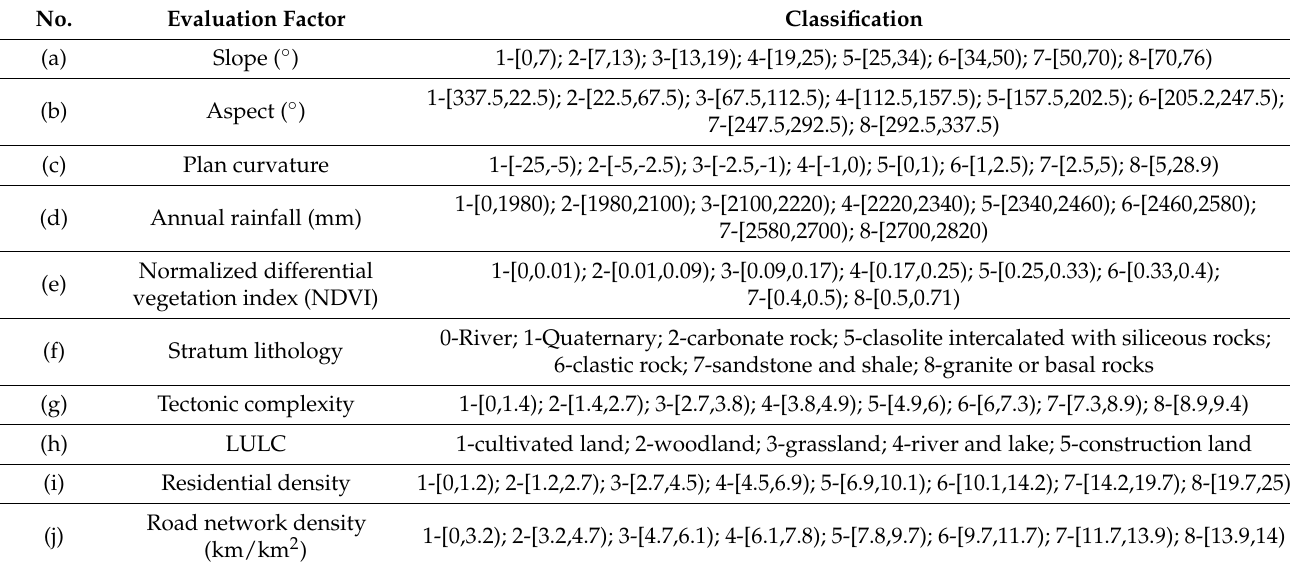
Table 1. Landslide affecting factors and their